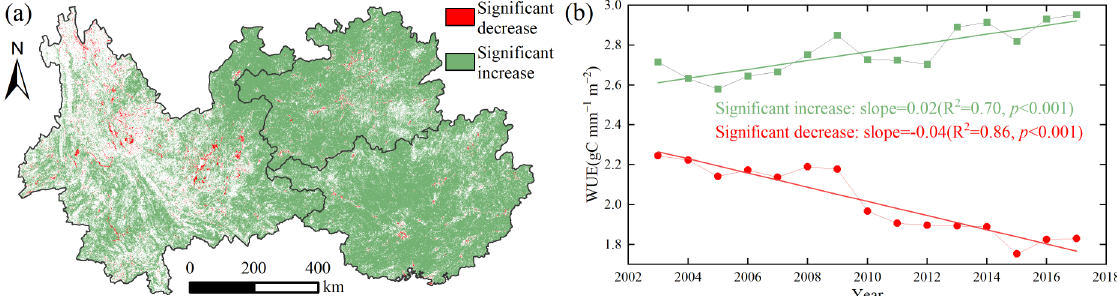
Figure 6. ( a ) Regional distribution of significant interannual variations in EVI from 2003 to 2017. ( b ) Interannual variation in ecosystem WUE in regions exhibiting significant changes.